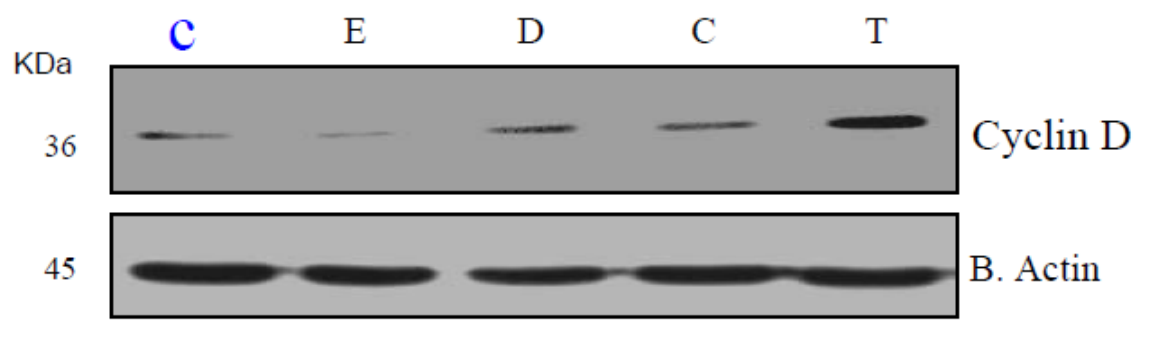
Figure 6. Expression of cyclin D protein in β -estradiol, DDT, coumestrol, and TCDD treated HeLa cells for 24 h. Western blot analysis of cyclin D expression was performed as indicated in the Materials and Methods. β actin expression was used to assess equal lane